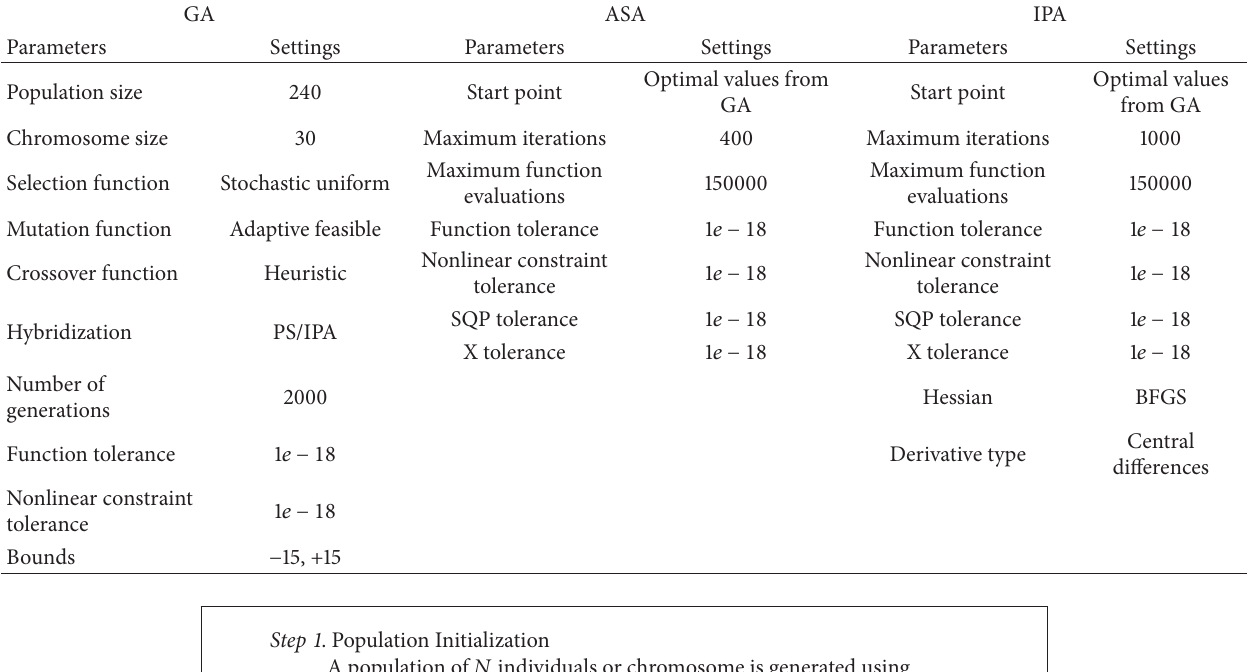
Table 1: Parameter settings of